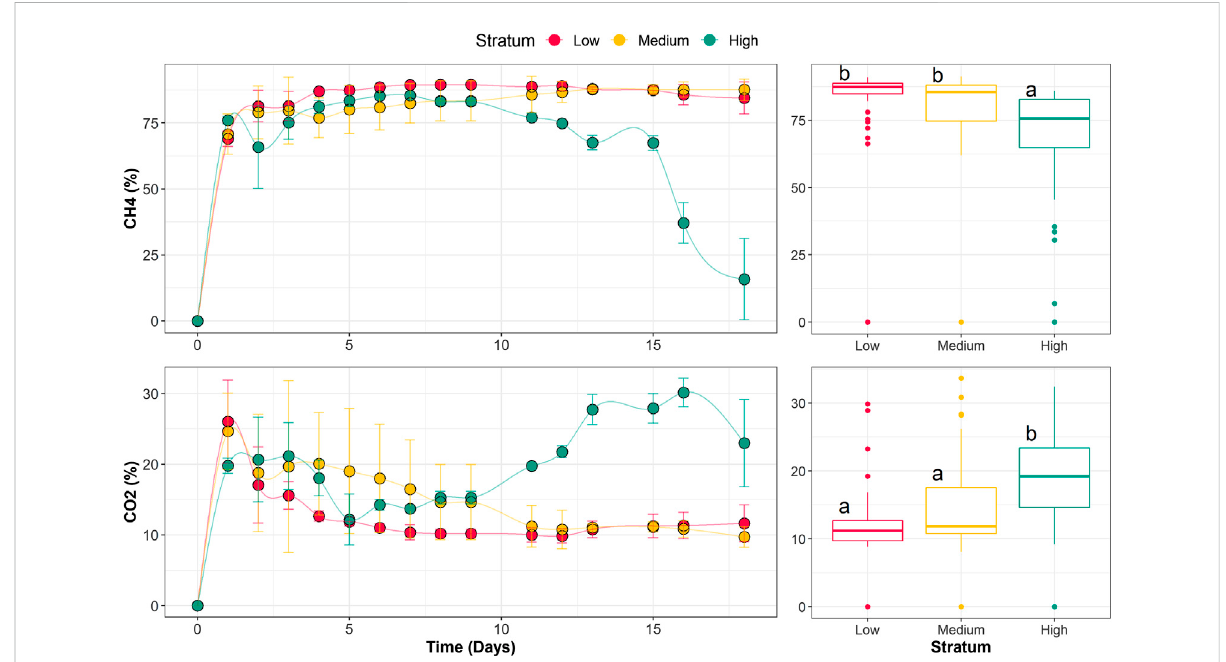
FIGURE 3 Volume percent of CH 4 and CO 2 in the biogas produced from the AD of OFMSW of the three socioeconomic strata; boxplots comparison of CH 4 and CO 2 in the biogas (different letters represent signi fi cantly different groups according to Tukey test).